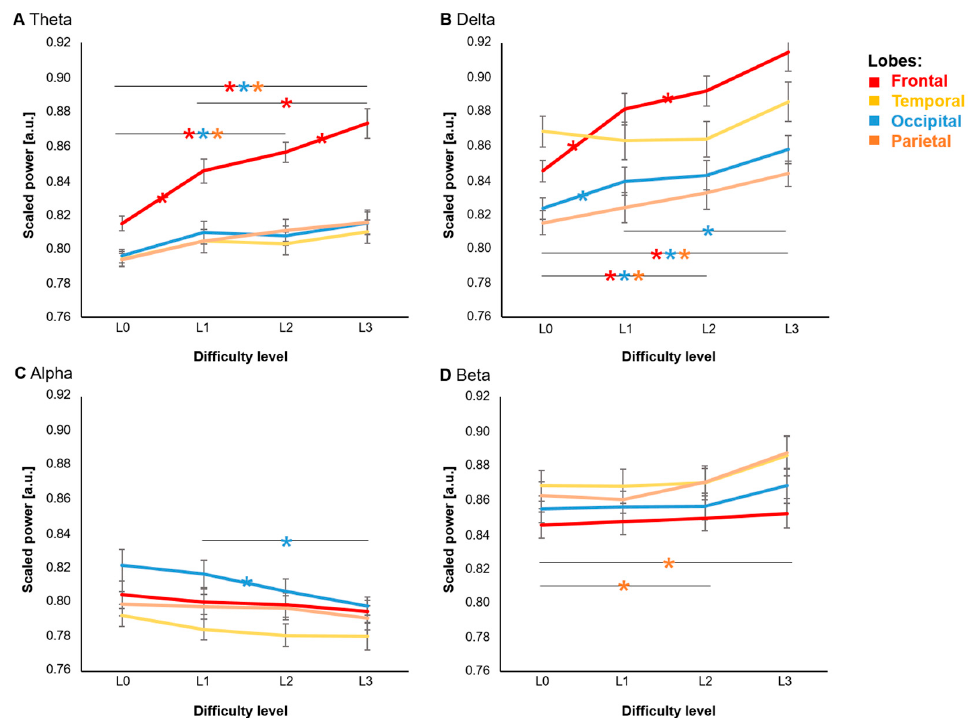
Figure 7. Marginal means with confidence intervals in three-factor ANOVA of power measures. The panels illustrate the logarithmically scaled power measure in the different EEG frequency bands ( A ): theta, ( B ): delta, ( C ): alpha, ( D ): beta. On the x -axis, the different conditions are mapped with increasing cognitive load (L0: baseline; L1: detection; L2: one-back; L3: 2-back). Data are averaged for electrodes over the four cerebral lobes (red: frontal; yellow: temporal; cyan: occipital; orange: parietal). Stars in the same color highlight significant post hoc comparisons across conditions for the respective lobe (e.g., a blue star on the line between L1 and L2 indicates a significant difference between these conditions for the frontal lobe with * p < 0.01). The robust replication of the primary hypotheses using the mobile technology can be observed as: increase of frontal theta (red curve and stars in Panel A) and occipital alpha (blue in Panel C) with increasing cognitive load (from L0 to L4) decreased with higher cognitive load. Further, a similar pattern emerges for the delta band and potentially the beta band as well. * p < 0.01, a.u.: arbitrary